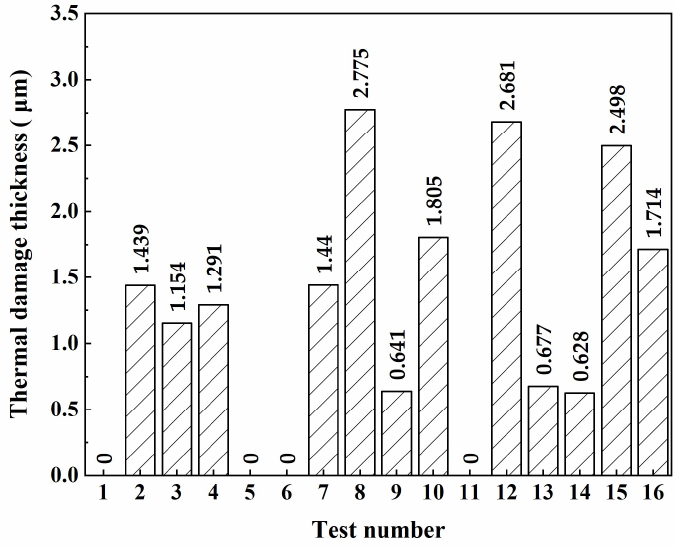
Figure 9. The thermal damage thickness was obtained in each experimental group.